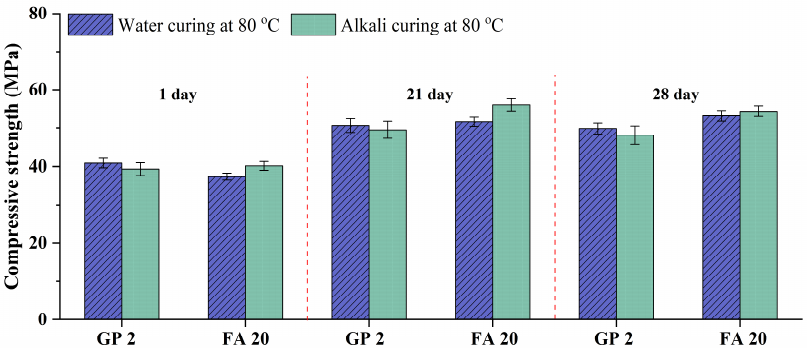
Figure 14. Compressive strengths of GP 2 and FA 20 mortars under alkali curing at 80 °C and water curing at 80 °C.